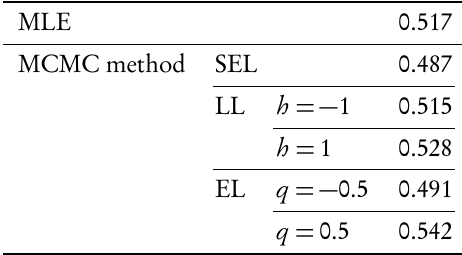
MLEs and Bayes estimates of P ( Y < X ) from RSS observations in Table